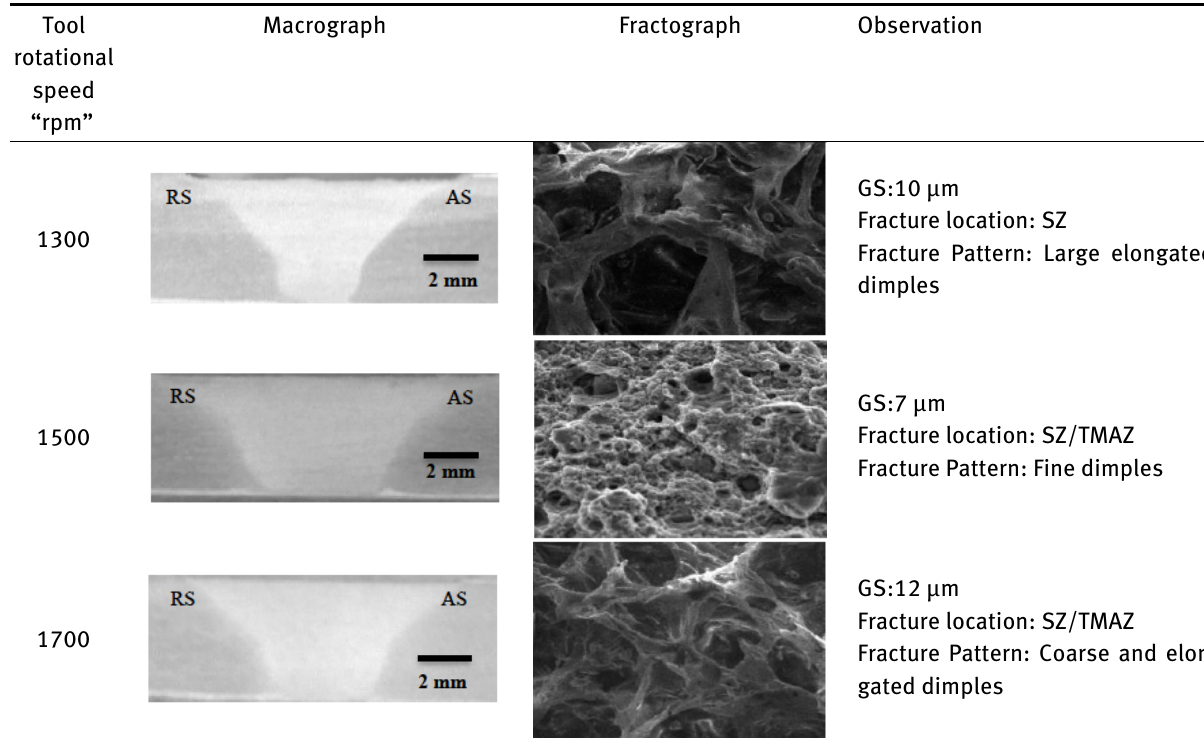
Table 5: Effect of tool rotational speed on macrograph and fracture